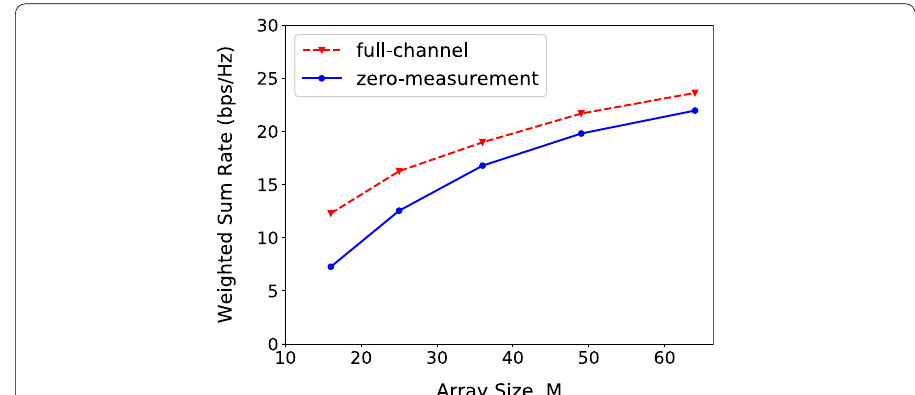
Fig. 6 The weighted sum rate with zero-measurement selection and full-channel selection, respectively. The system setup is that a changing number of antennas base-station select 4 users out of 100 users for downlink beamforming based on measured